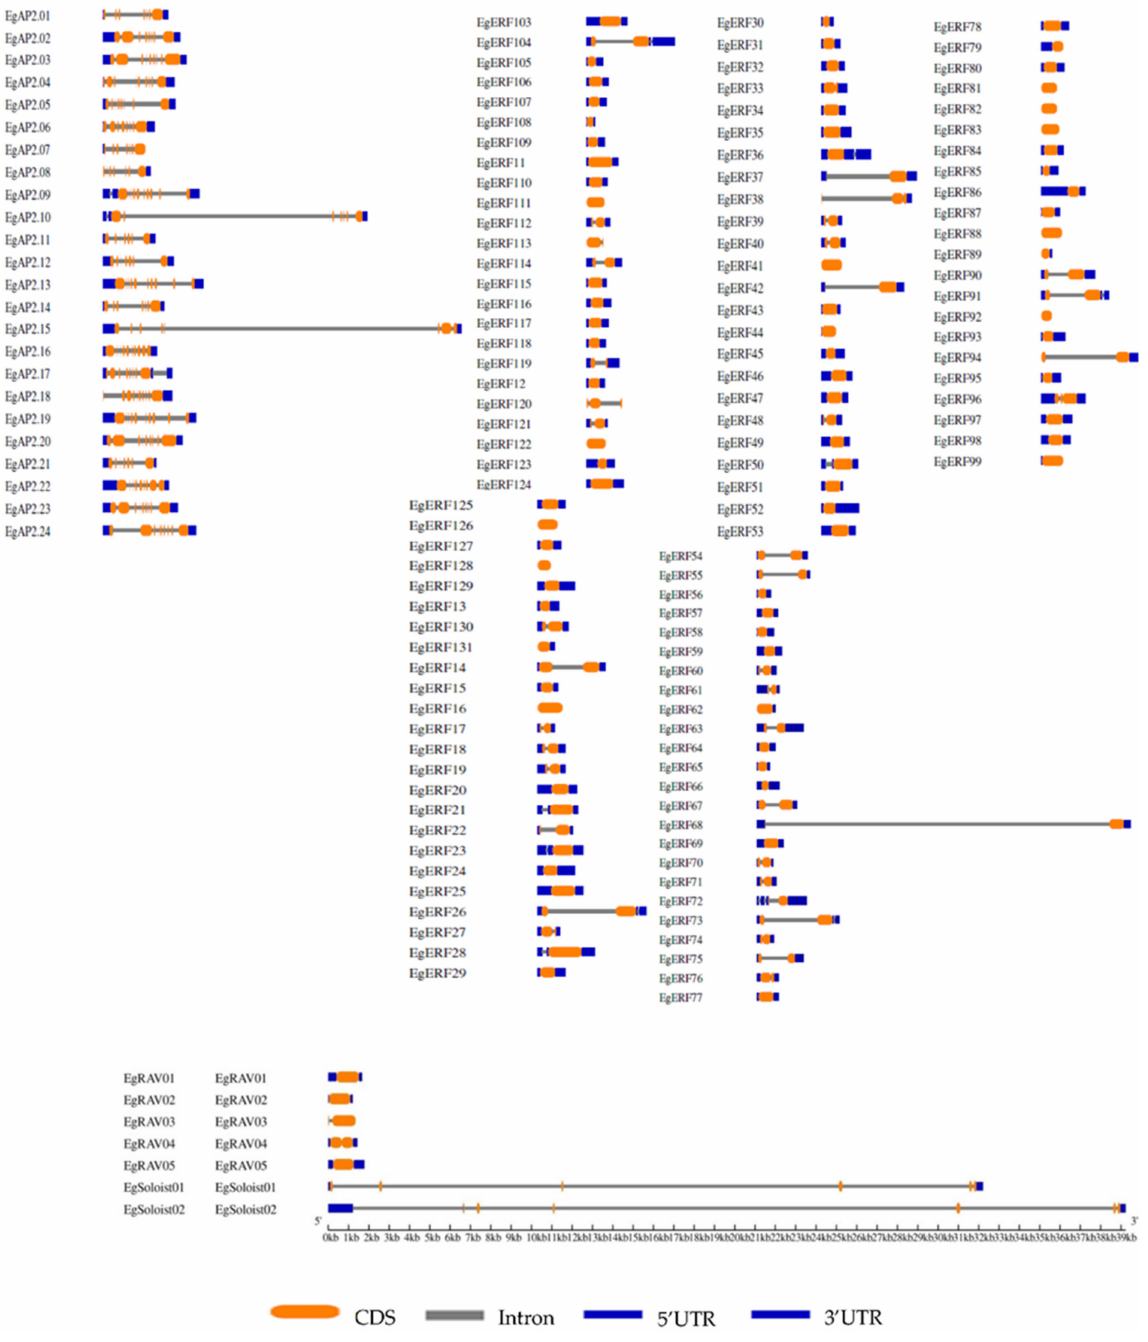
Figure 1. Intron-exon organization of 172 AP2/ERF transcription factors in the oil palm genome. Coding sequences (CDS) are represented by orange color blocks; 3 (cid:48) & 5 (cid:48) un-translated (UTR)regions are represented by grey color blocks; intron regions are represented by grey color